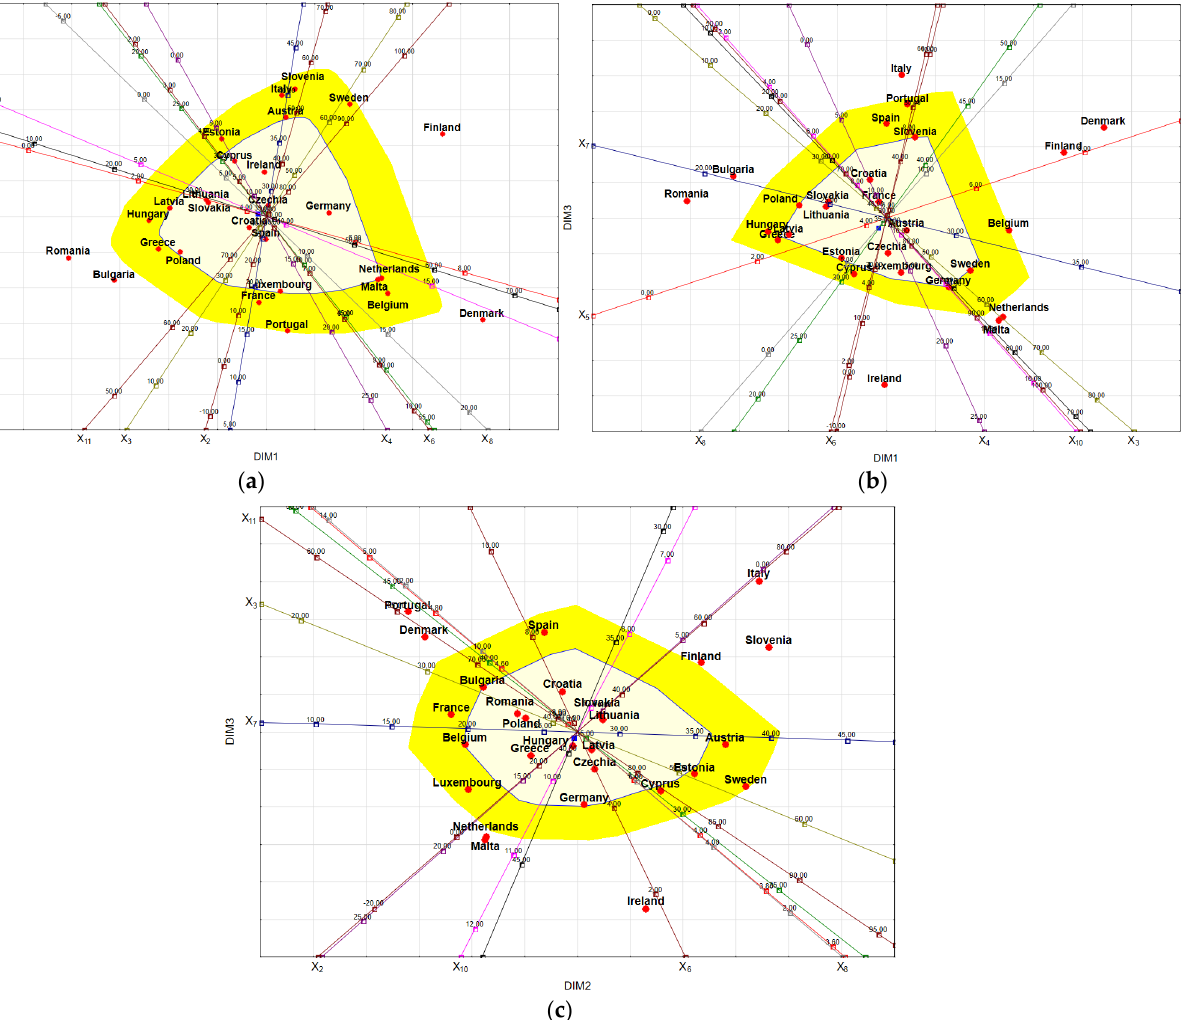
Figure 6. The standardized biplot for indicators characterizing the digital maturity of SMEs in the EU-27 for the first two principal components ( a ), for the second and third principal components ( b ), and for the first and third principal components ( c ).